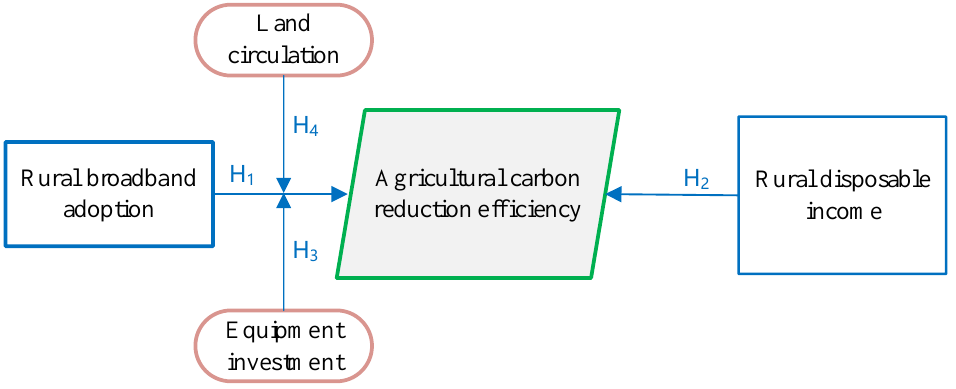
Figure 1. Theoretical model of this study.